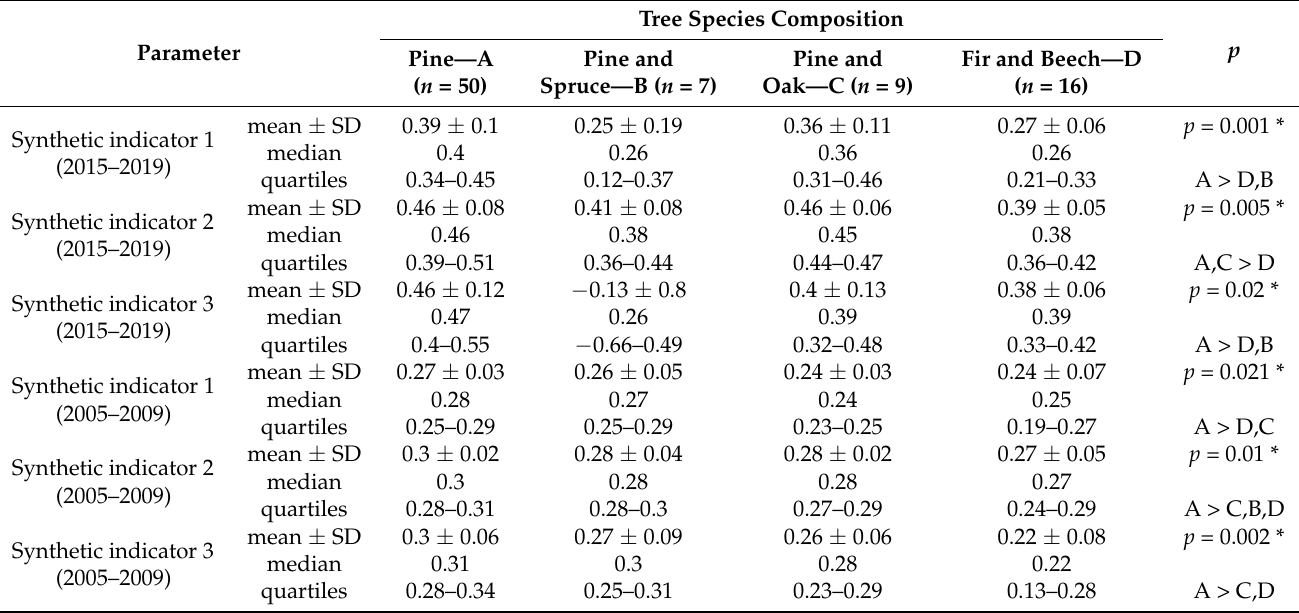
species composition.